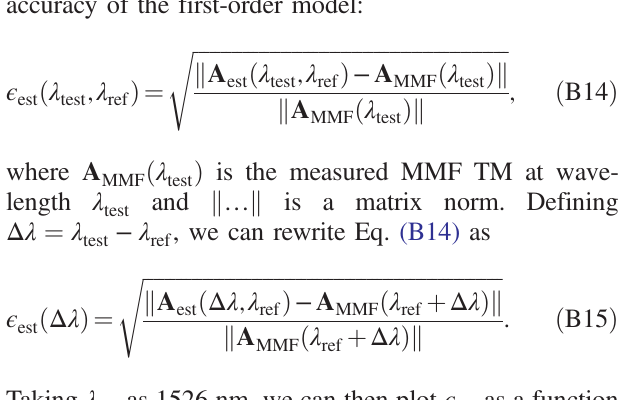
FIG. 13. Validation of the first-order model of Appendix A 2 using measured multiwavelength TMs from a step-index MMF [26]. The normalized error of the TM predicted by the first-order model compared with the actual measured TM ( ϵ the difference in reference and test wavelengths ( Δ λ ) is increased. Different submatrices of only the lowest-order modes are considered: that is, submatrices of size N × N , with N ¼ 30 , 72, 110, 132, 156, 210, 420. For lower-order submatrices, the first-order model is seen to be valid over a larger wavelength